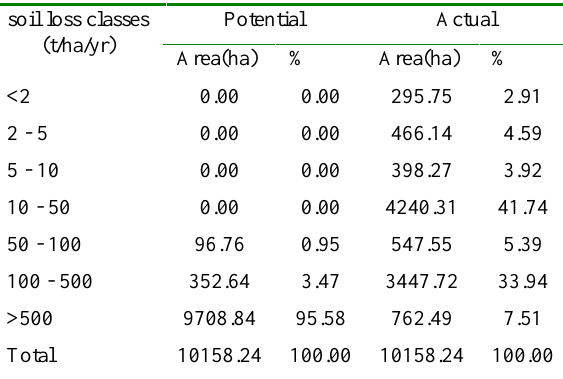
as of potential and 0.0009 to 12,513 tons/ha/year for actual soil loss. As compared to potential soil loss, 95.58% of city area is fallen within the highest category of class with erosion rates greater than 500 tons/ha/year( Table 3 and Figure 5), whereas only 7.51% of city area is found under the same category in case of actual soil loss estimation (Table 3 and Figure 4 ). Implication of spatial distribution of such rate shown in Figure 4 indicates that land cover as forest, bush, shrub and grass present in the natural condition in the